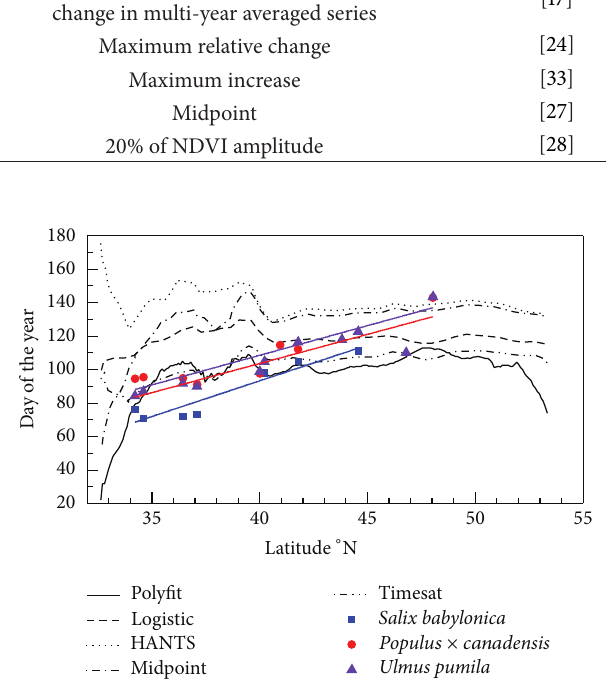
Figure 3: The variation of five satellite-derived SOS measures averaged from pixels of broadleaf forest and mean FLD of three broadleaf plants along with latitude. Purple, red, and blue lines are regressions lines for FLD of the three broadleaved plant species,